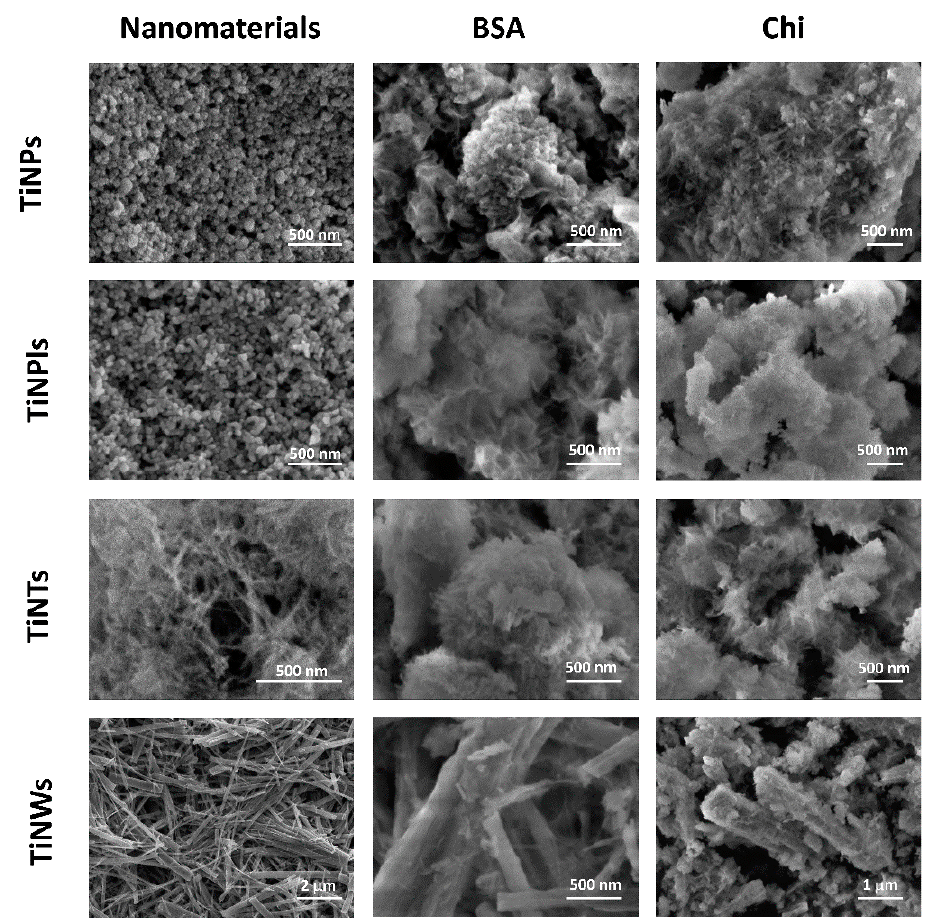
Figure 8. SEM micrographs of the TiO 2 nanomaterials and the precipitates obtained in the precipitation systems containing in addition bovine serum albumin (BSA) or chitosan (Chi) after 60 min and 120 min, respectively. c (CaCl 2 ) = c (Na 2 HPO 4 ) = 4 × 10 − 3 mol dm − 3 , γ (TiNMs) = γ (BSA) = 100 mg L − 1 , γ (Chi) = 15 mg L − 1 , pH init = 7.4, ϑ = (25 ± 0.1) °C. Table 3. Zeta potential of TiO 2 nanoparticles (TiNPs), nanoplates (TiNPls), nanotubes (TiNTs), nanowires (TiNWs), bovine serum albumin (BSA), and chitosan (Chi) TiO 2 nanomaterials in